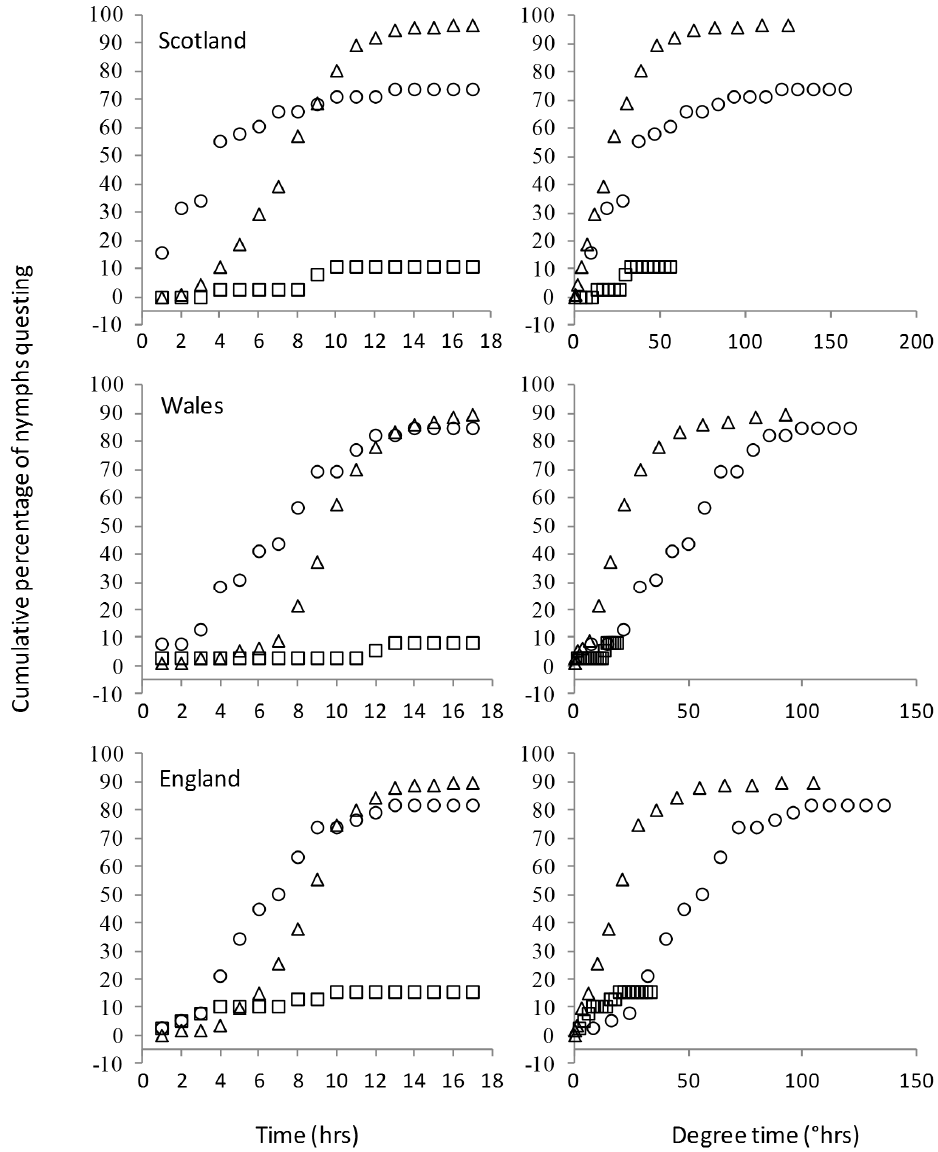
Figure 4. Comparison of the three UK populations in which temperature was increased hourly ( D ) by 1 6 C from 5 6 C or held constant at 15 6 C ( # ) or constant at 9 6 C ( % ) for 17 hours. In the left-hand panel cumulative questing is shown against time; in the increasing temperature experiment 9 u C and 15 u C were at 5 and 11 hours respectively. In the right-hand panel cumulative questing is shown against degree- time.